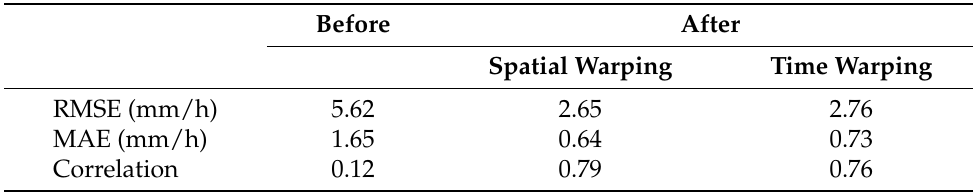
Table 1. Statistics before and after warping compared to the “truth” v . The statistics are computed over the whole domain and all time